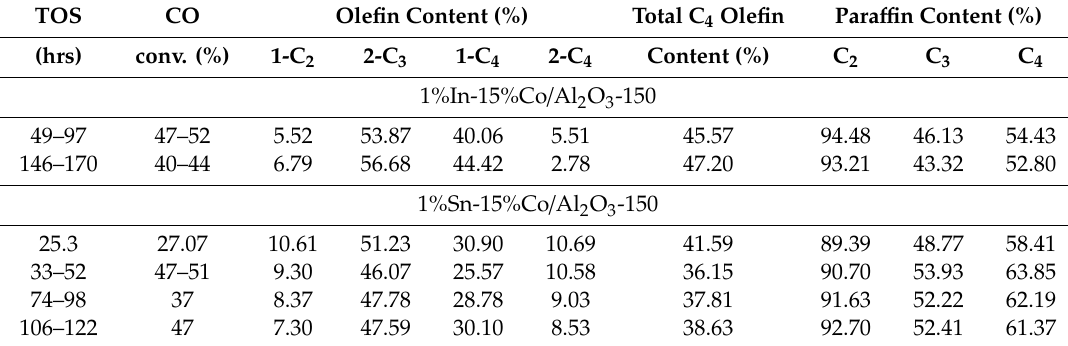
Reaction conditions: 220 ◦ C, 2.2 MPa, and H 2 / CO = 2.1. C 4 olefin selectivity, % = 100 × rates of all C 4 olefins / rates of all C 4 hydrocarbons; 1-C 4 olefin selectivity, % = 100 × rate of 1-C 4 olefin / rates of all C 4 hydrocarbons; 2-C 4 olefin selectivity, % = 100 × rate of 2-C 4 olefin / rates of all C 4 hydrocarbons.